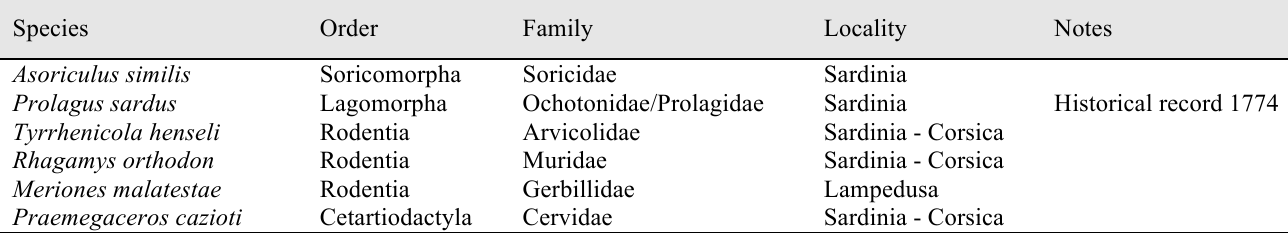
Table 2. Extinct endemic species during Holocene in Italy (from Turvey 2009).